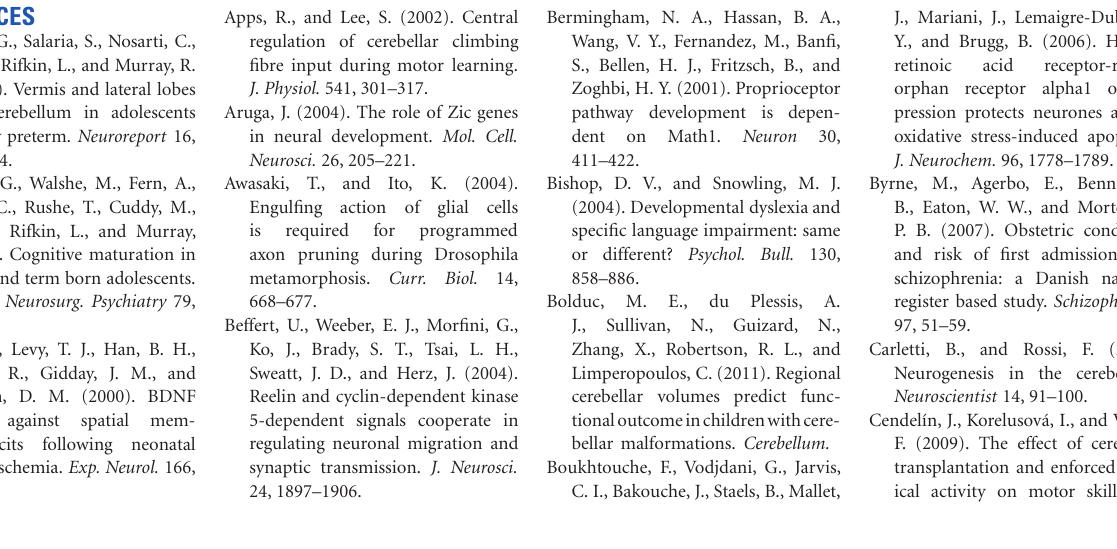
FIGURE 4 | Premature baby born at 27 gestational weeks and MRI performed at 39 gestational weeks. Left panel: the sagittal T2-weighted image shows reduced size of the posterior fossa (vertical tentorium), small vermis, and pons with a hemorrhagic dark spot on the anterior vermis (left arrow) and bright signal in the pons (right arrow)